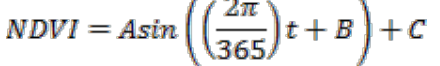
signatures to each pixel. Thus, the values are slightly varied in between each cell. After subtracting the modelled seasonal effects from each pixel’s time series data, the residual NDVI values for all the 25 pixels are plotted in Figure 7-A and 7-B . The residual NDVI values are now mostly between ±0.2. Figure 7-B is 3D version of Figure 7-A. For those residual values below -0.2, we have to consider the causes.